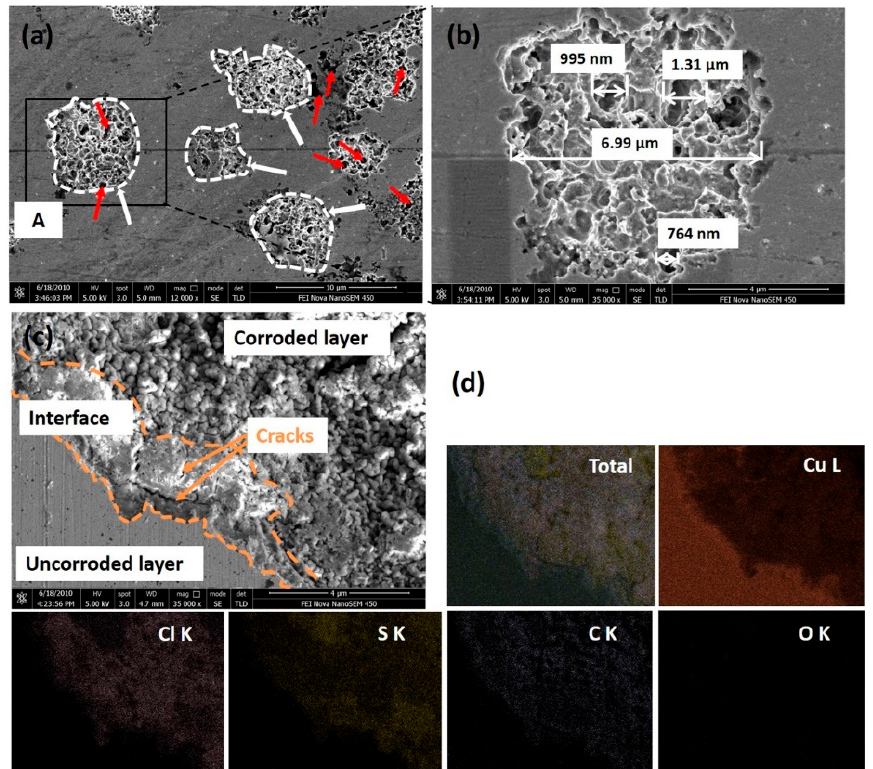
Figure 7. HR-SEM images and EDS analysis of the 58.6% reduced Cu surface after the electrochemical experiments: ( a ) HR-SEM images of the corrosion pits; ( b ) magnification of site A in Figure 7a; ( c ) morphology of corroded layer, interface and uncorroded layer; and ( d ) EDS surface scanning mappings of Figure 7c.